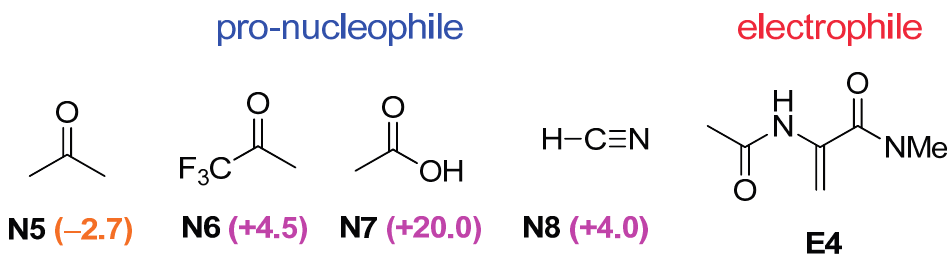
Figure 4. Various acetyl and cyanide nucleophiles screened with the optimal electrophile E4 for bicyclic guanidine-catalyzed conjugate addition reactions. ∆∆ G ≠ values (in kJ · mol − 1 ) are given in